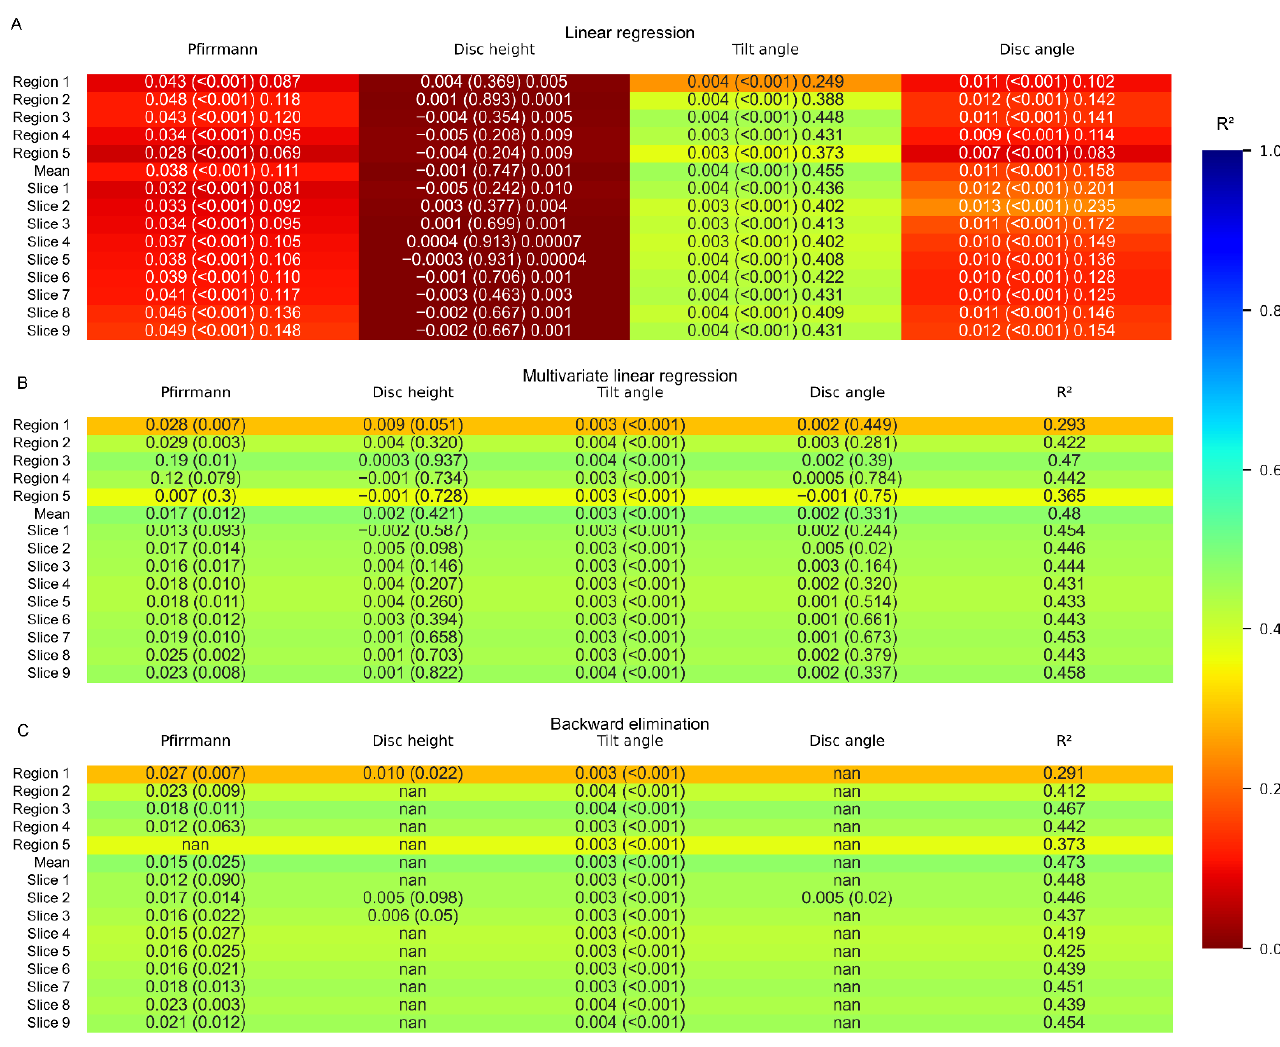
Figure 5. Linear regression analysis. ( A ) Univariate linear regression, ( B ) multivariate linear regression and ( C ) multivariate linear regression with backward elimination colored according to the coefficient of determination for the regression between the deformation and the disc characteristics. The cells contain β ( p -value) R 2 for A and β ( p -value) with R 2 in a separate column for B and C. Region 1 = anterior, Region 5 = posterior, Slice 1 = left, and Slice 9 = right.